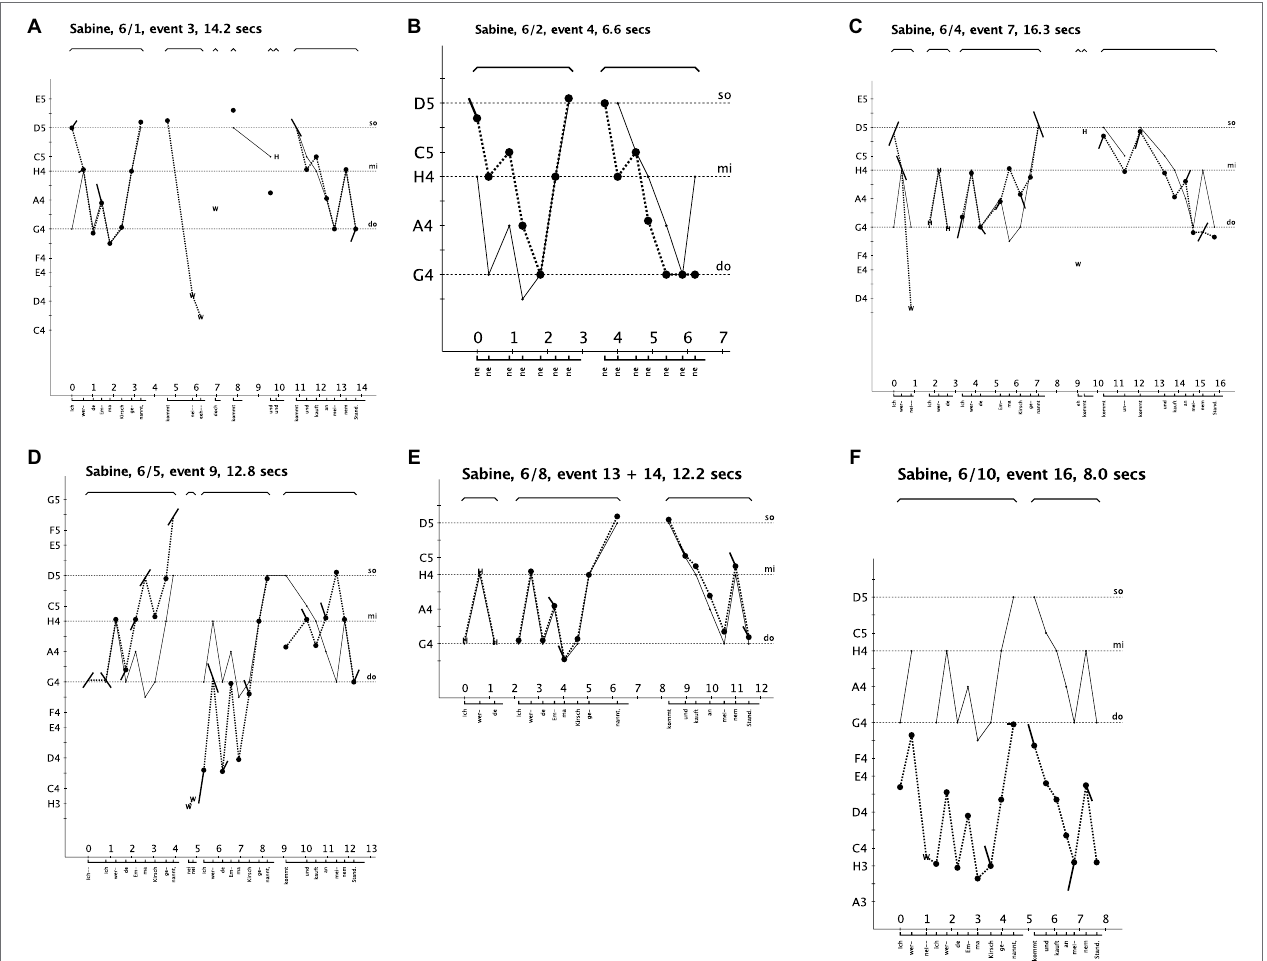
FIGURE 4 | The song model is represented by the thin, continuous line. Sabine’s production is shown by the syllables and duration at the bottom and by the dots representing the quality and tonal position of the pitches which are connected by the dotted line. The x-axis represents time in seconds, and the y-axis pitch as continuum that is subdivided into the pitch categories of our Western tonal system. The symbol W means “Words,” and H stands for “Help” given by the teacher. The title at the top of each figure indicates the name of the singer, the number of the song (here number 6), the solo version, the event in the sequence (see overview in Figure 3 ) and the duration of the song. (A) Sabine interrupts her first version (see W) and is given help with one syllable (see H). (B) After the first reproduction, she sings a tune that she considers to be similar. (C) She gets help to begin the song (see H) and again at the beginning of the second phrase. (D) After the first phrase, she says “no, no” (see W), and she begins again. (E) In the new session, she asks for giving the beginning (see H). (F) Her last solo version (number 10, event 16), she sung rather fast and